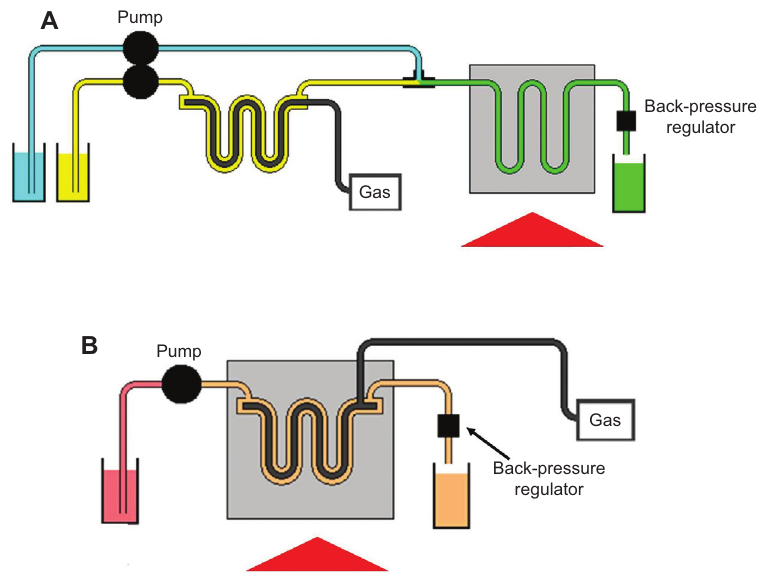
Figure 1 (A) “Tube-in-tube” and (B) “on-demand” approaches to performing reactions involving gaseous reagents. [Modified from an original figure from